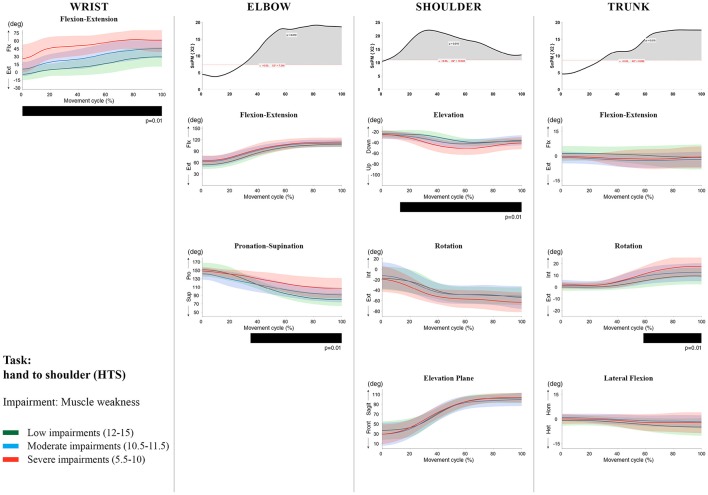
Impact of muscle weakness on UL movement patterns in children with uCP during the HTS task for all joint angles. Each column corresponds to a joint (from left to right: wrist, elbow, shoulder, and trunk). The top image of each column is the SPM output of the vector field analysis (non-parametric Canonical Correlation Analysis test, except for the wrist, where a non-parametric linear regression was computed). For visualization purposes, kinematic data was grouped according to the level of motor impairments, i.e., muscle weakness total score: low impairments (score between 12 and 15, i.e., values above percentile 75), moderate impairments (score between 10.5 and 11.5, i.e., values between percentile 25 and 75), and severe impairments (score between 5.5 and 10, i.e., values below percentile 25). Below, mean (bold line) and standard deviation (translucent area) of the low impairments (green), moderate impairments (blue), and severe impairments (red) of each vector component and the respective post-hoc SPM{t} output. The black bar under each kinematic profile indicates clusters of significant influence of the impairment level on the kinematic variable.